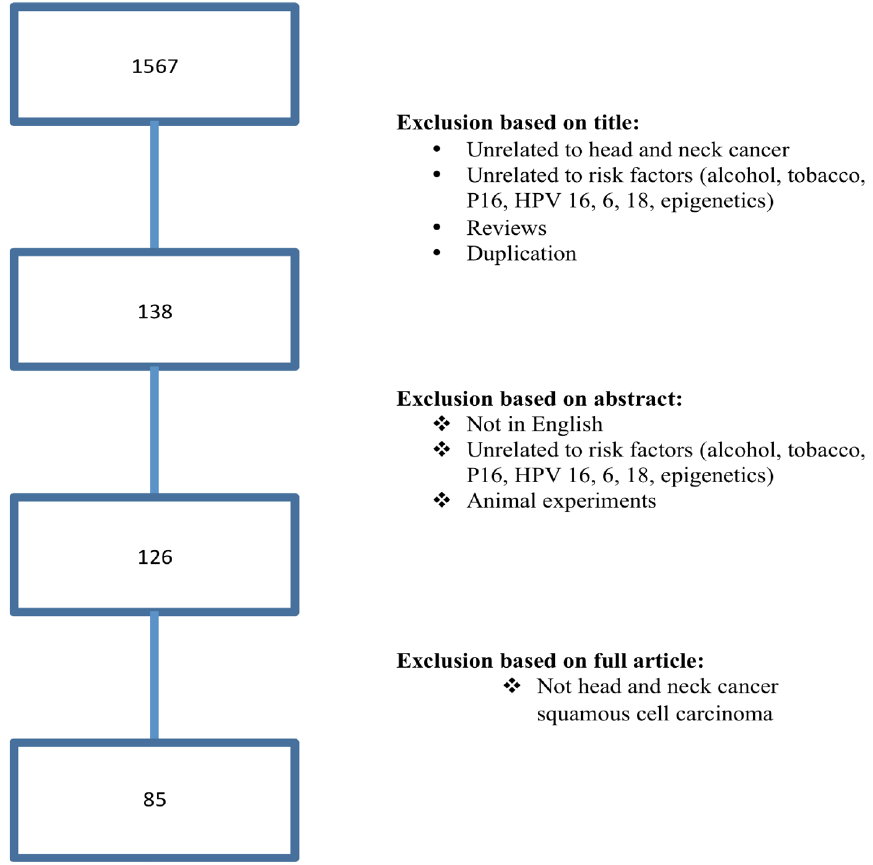
Figure 1. Flow diagram of search and study selection process. Following the guidelines of the Meta-analysis of Observational Studies in Epidemiology group (MOOSE), we performed a broad and sensitive search on online databases to identify the studies that examined associations between DNA methylation and HNC associated with risk factors (alcohol, tobacco and HPV infection). A systematic literature search for relevant studies up to June 2020. In this study, we considered the clinical endpoints overall survival (OS) and disease specific survival (DFS) as acceptable outcomes. The prognostic value was demonstrated using hazard ratio (HR) with 95% confidence interval